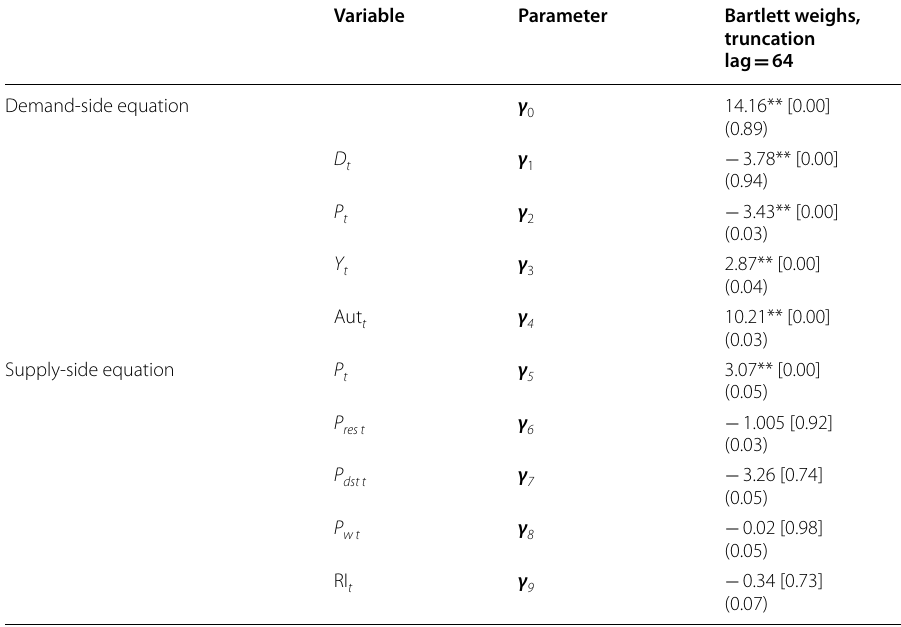
Table 1 Static disequilibrium switching estimation